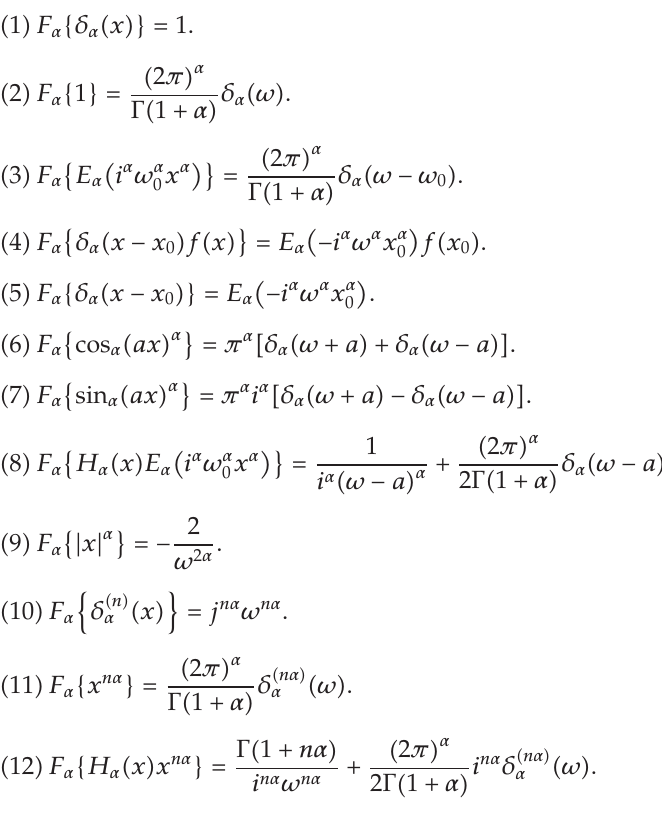
Table of Local Fractional Fourier